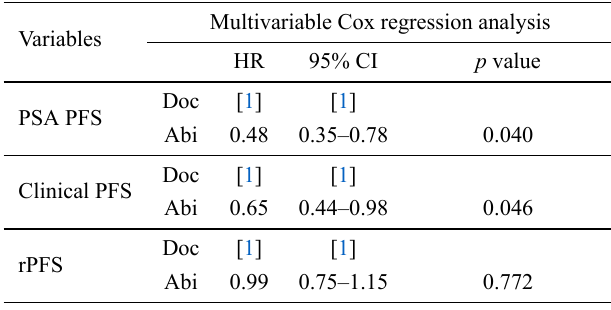
Table 4. Multivariable Cox regression analysis of time-to-event outcomes in patients treated with Abi according to AR-V7 status.